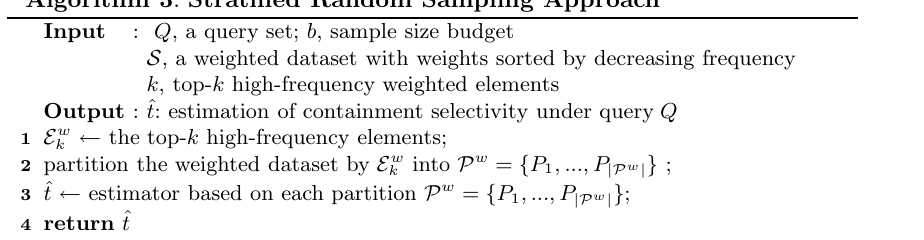
Algorithm 3 : Stratified Random Sampling